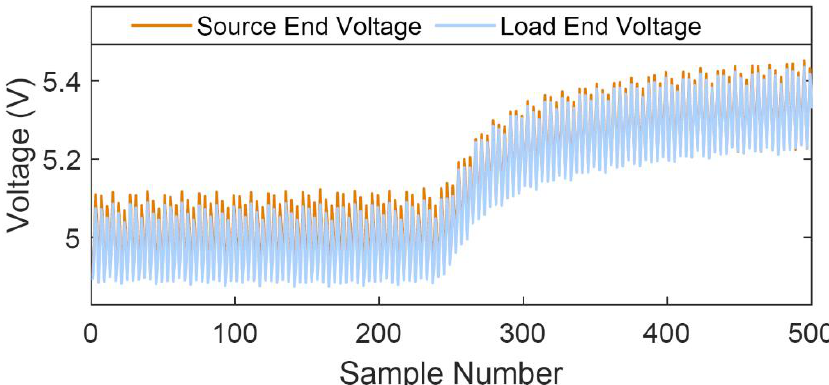
Figure 9. Event 3: data used for analysis of load change event—voltages at the source and load ends. The fault detection analysis corresponding to the data window where the voltages were sharply rising is shown in Figure 10. The γ and δ threshold values were the same as the previous cases. A step change was detected by the algorithm because of the sudden large load change. The calculated IQR value for this moving window was 0.09 V. As it is greater than γ , there exists the possibility of a series arc fault. The detection voltage ( V Detect ) is examined next. As seen in Figure 10, the detection voltage was negligible and close to zero, as expected. Hence, the criterion to detect a series arc fault ( | V Detect [ k ] − F IQR | < δ ) was not satisfied. This indicates the absence of a series arc fault even though a step change was